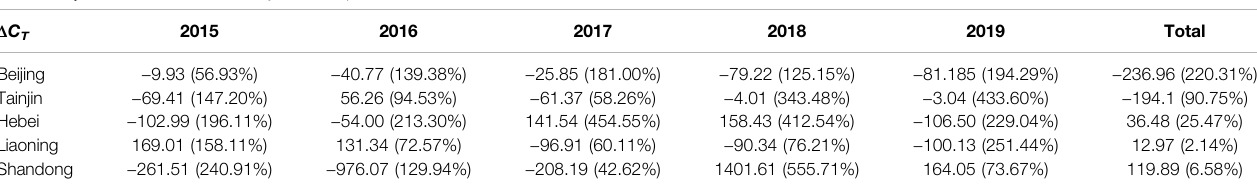
TABLE 7 | Carbon emission intensity effect in provinces and cities. Δ C